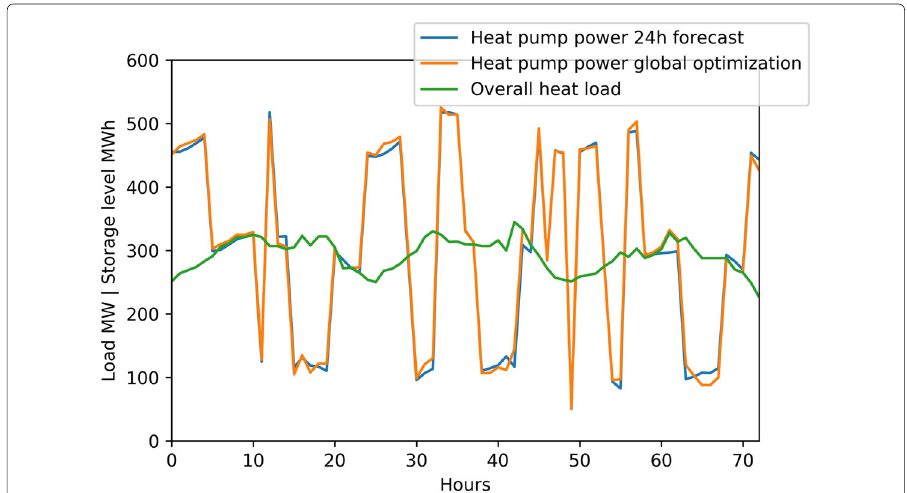
Fig. 3 Comparison of heat pump operation for naive approach, 24 hours forecast and global optimization